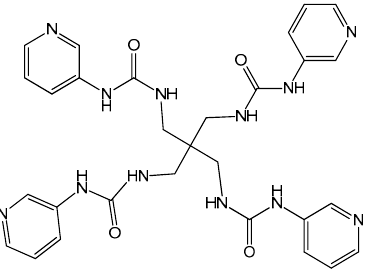
Figure 1. The molecular structure of the X-shaped urea-based ligand L .